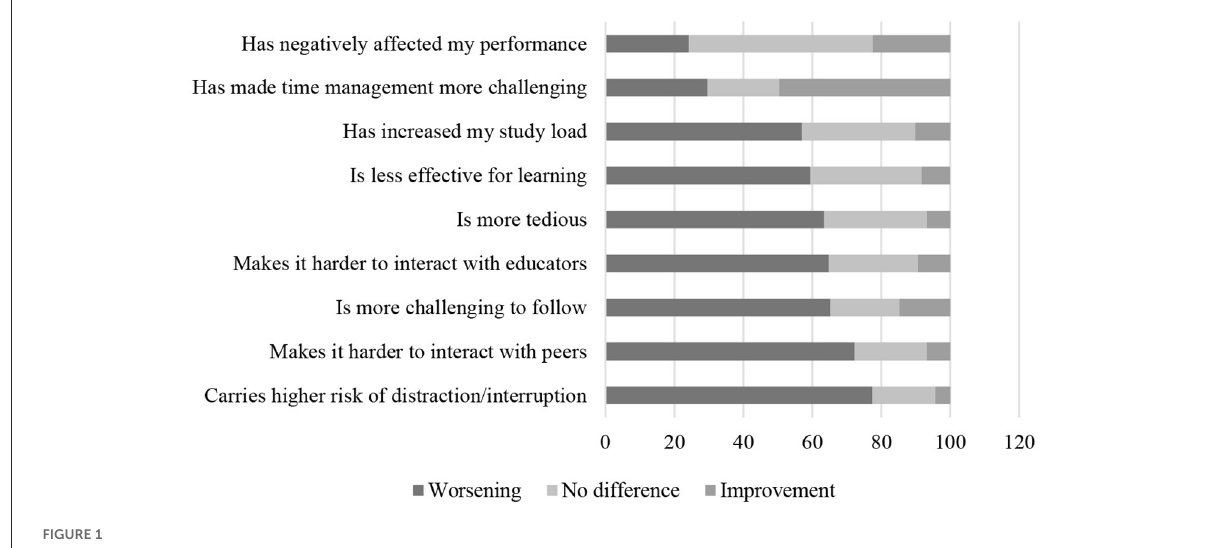
FIGURE1 Opinions on